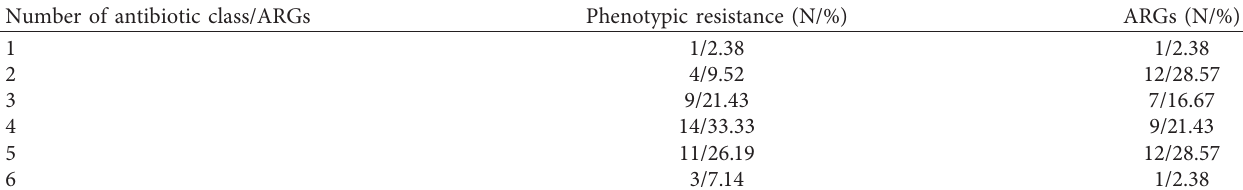
Table 4: Distribution of antimicrobial resistance phenotypes and antimicrobial resistance genes (ARGs) in uropathogenic E. coli isolates ( n �